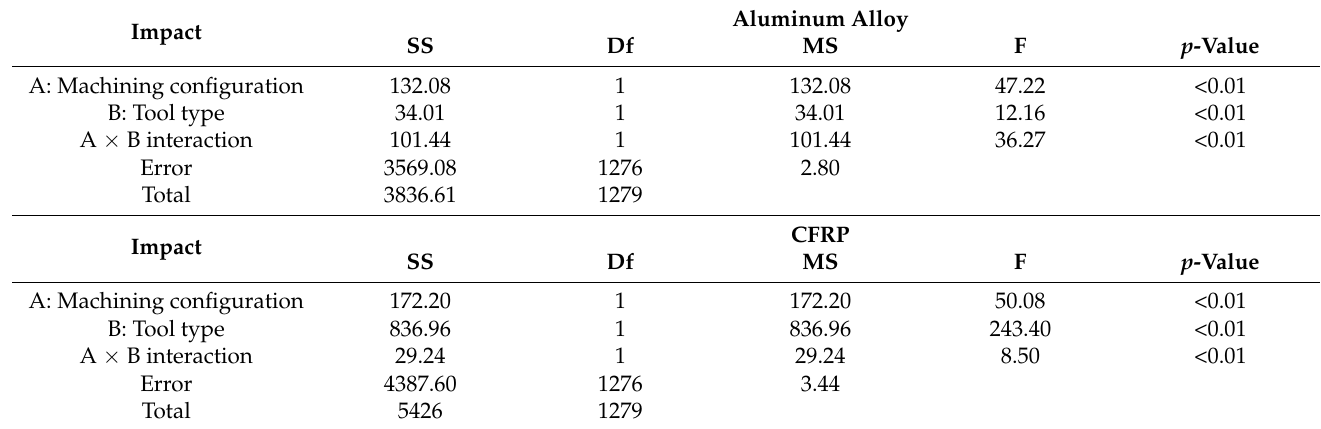
Table 5. Two-factor analysis of variance for Rmax surface roughness parameter depending on the machining configuration and the type of